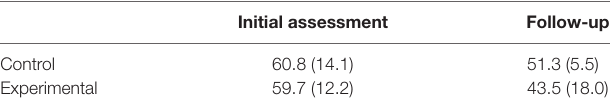
Table 6 | Mean (sD) Pcl-M scores.